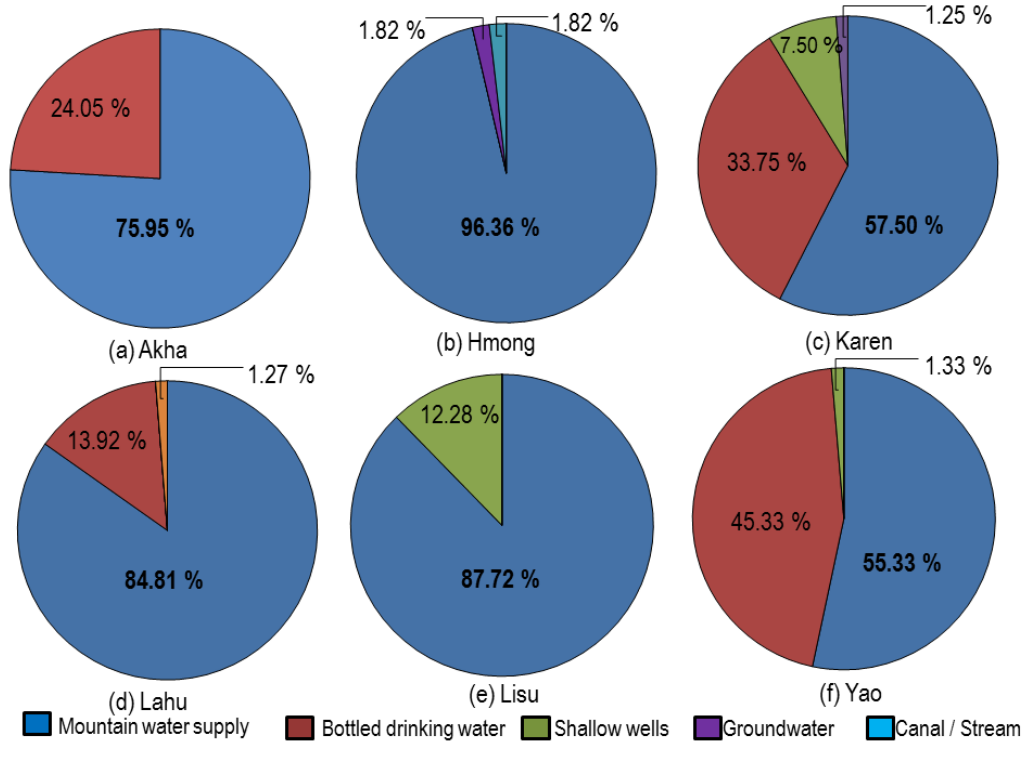
Figure 2. ( a–f ): Drinking water sources of six hill tribe groups.